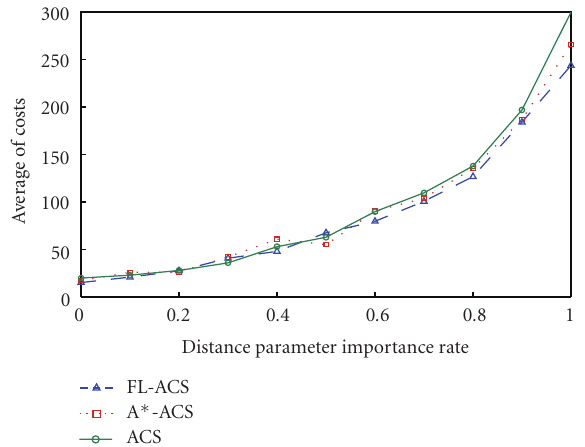
Figure 16: Average of 10 randomly selected O/D pairs cost averages for di ff erent “Incident Risk” parameter importance rates. A comparison between performance of ACS, A ∗ -ACS, and FLACS algorithms is